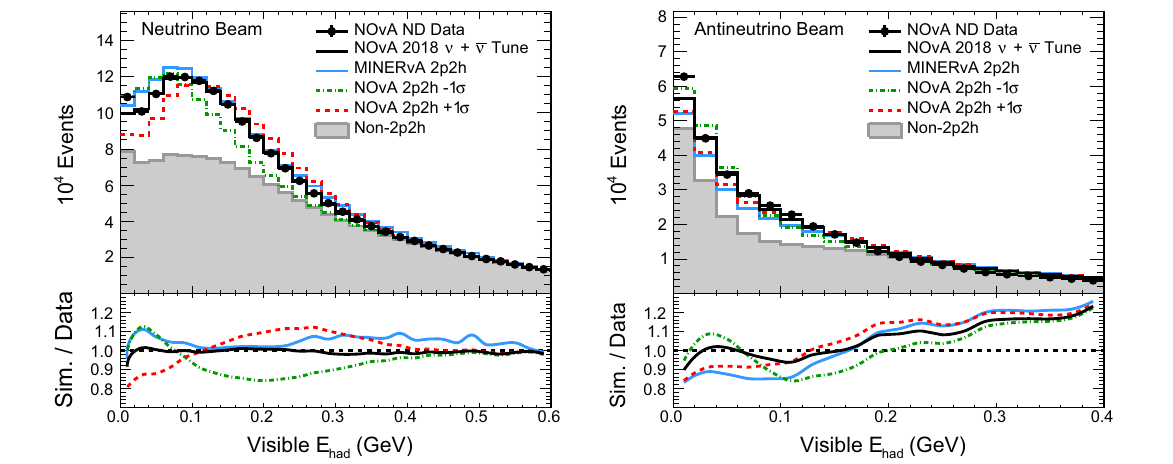
Fig. 13 Comparison of reconstructed visible hadronic energy distri- bution in ND data (black dots) to various simulations for neutrino beam (left) and antineutrino beam (right) running. The solid black curves cor- respond to GENIE predictions with the full set of adjustments described in this paper, while the red and purple dotted curves are the simulation somewhat better than the antineutrino simulation, but in